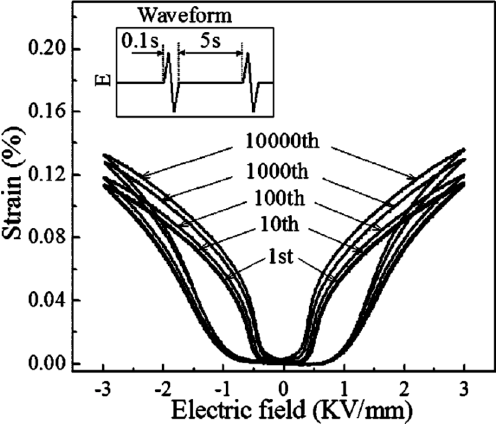
Figure 6. Electric-fatigue in Mn-doped BaTiO 3 ceramic [41].